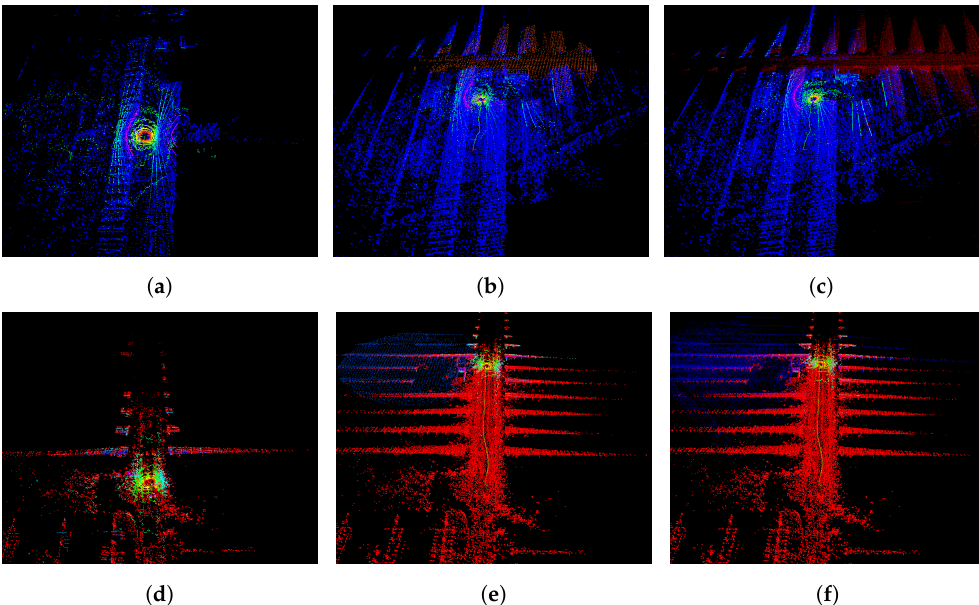
Figure 4. Real-world experiment—the various phases of the proposed method for agent J 1 ( above ) and J 2 ( below ). The blue and red points correspond to the point clouds generated by J 1 and J 2, respectively. ( a , d ) LOAM initialization; ( b , e ) minimal proximity search was successful, an agent receives a spherized down-sampled map from the other agent and registers this in its own map; ( c , f ) each agent receives the full map from the other agent, as they are within short communication range. The agent aligns the incoming map with its own map using the transformation acquired from the spherized registration.